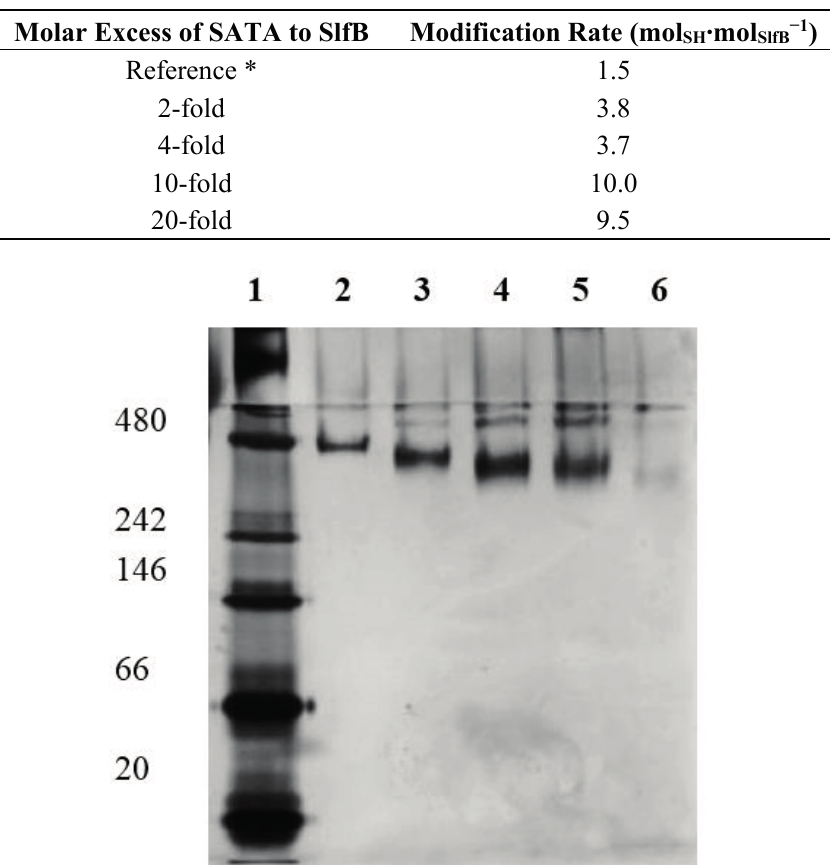
Table 3. Modification rate of SlfB modified with SATA; determined by Ellmann’s reagent; * native SlfB was used as a reference.